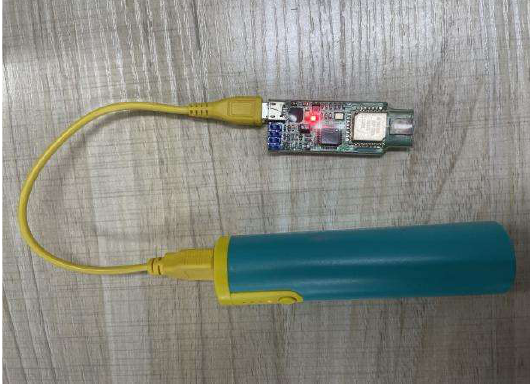
Figure 10. The UWB node wired to a power source.